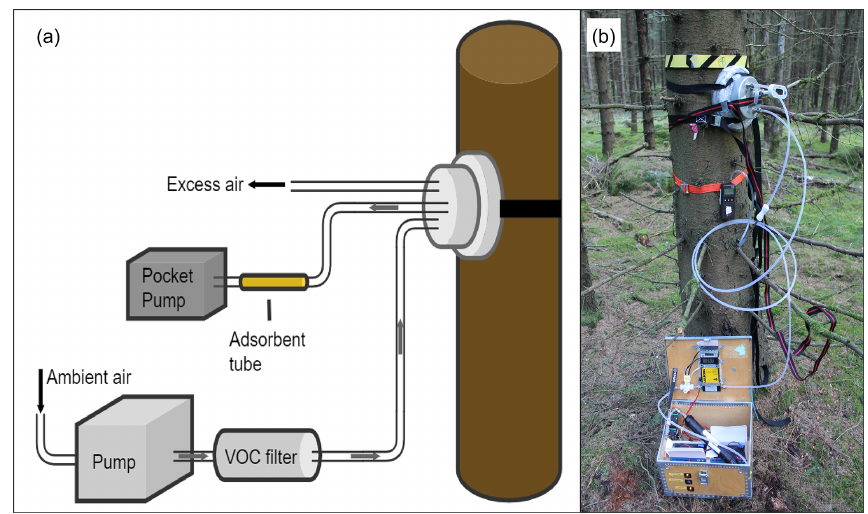
Figure 3. The experimental setup (a) and a field photo (b) of the tree trunk chamber mounted on a Norway spruce trunk. The chamber is connected to a pump box used to provide BVOC- and O 3 -free purge air. The BVOC samples were collected with adsorbent tubes by extracting the air from the chamber using a pocket pump.